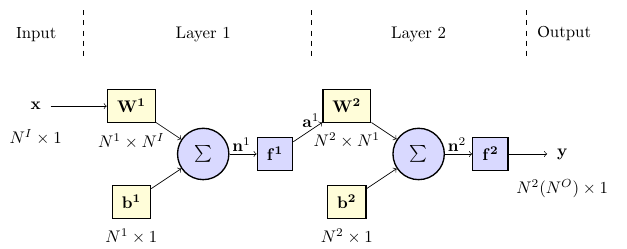
Figure 1. Multilayer feedforward neural